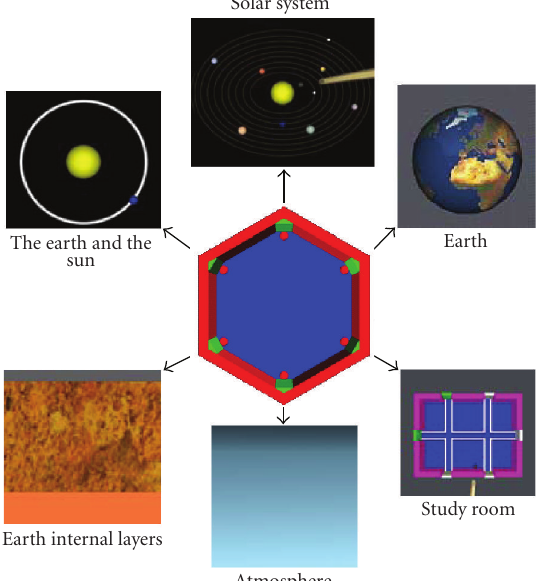
Figure 1: The structure of the